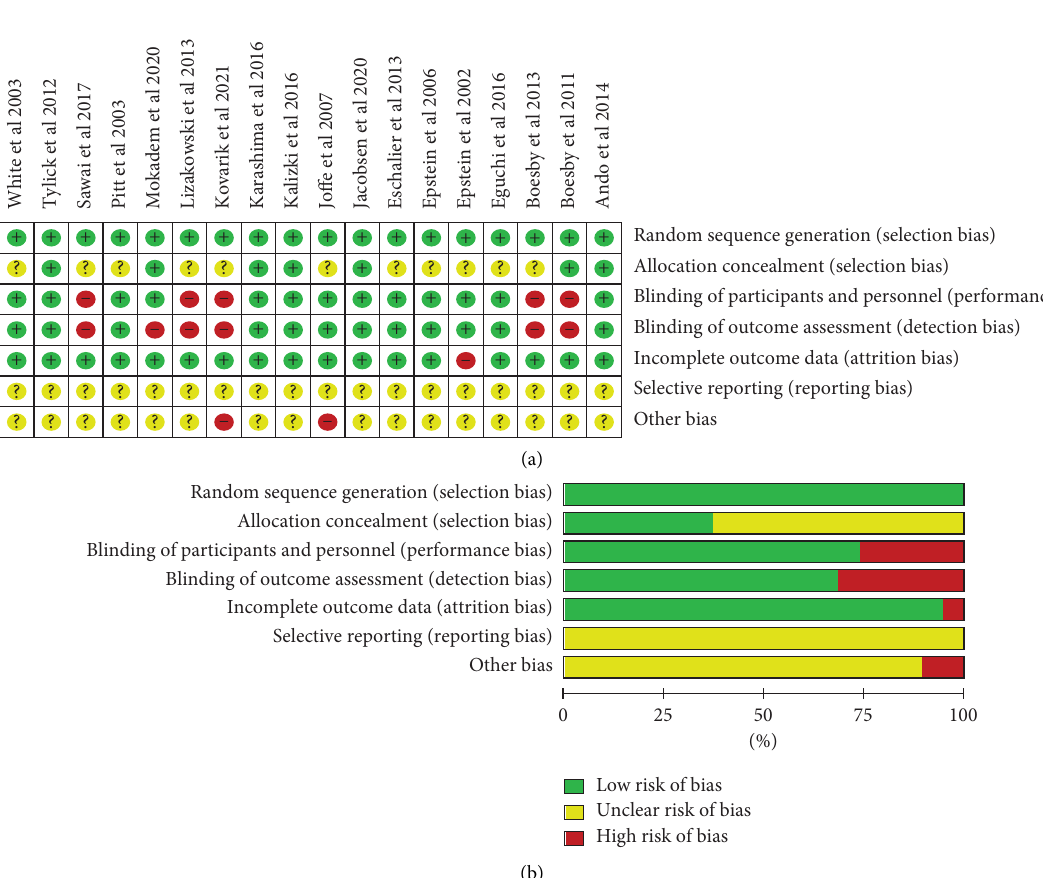
Figure 2: (a) Risk of bias summary: review authors judgements about the respective risk of bias item for each involved study. (b) Risk of bias graph: review researchers’ judgements about the respective risk of bias item presented as percentages across all involved